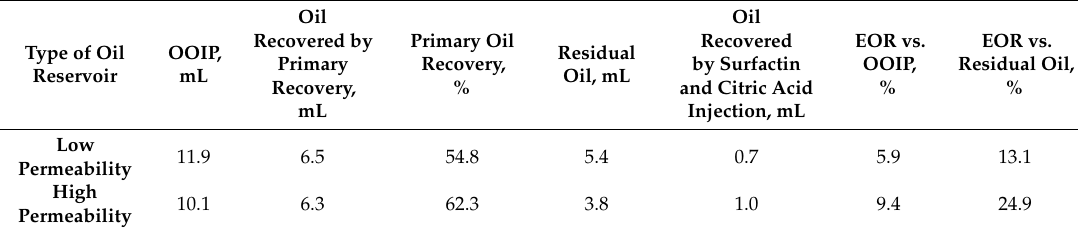
Table 3. Results of the core flooding experiments.